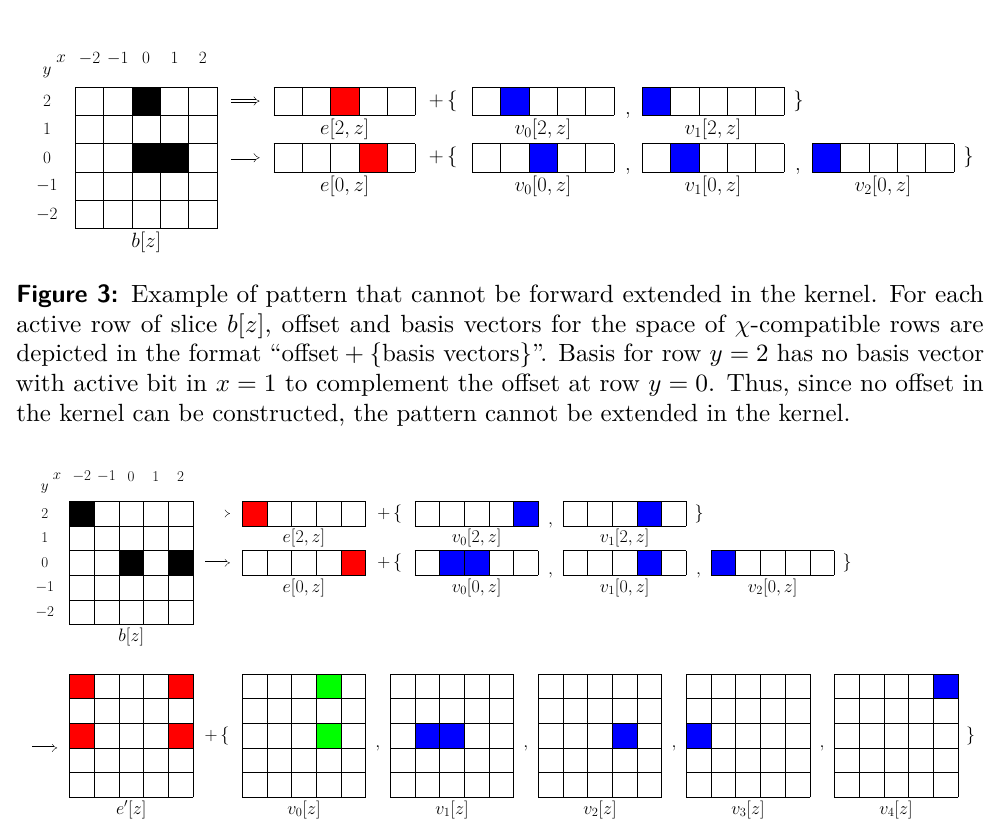
Figure 4: Example of pattern that can be forward extended in the kernel. Above, offset and basis vectors for the space of χ -compatible rows are depicted. Below, offset and basis vectors for the space of χ -compatible slices are depicted, with separation between basis vectors in the kernel (in green) and outside the kernel (in blue). The offset in the kernel can be built as e 0 [ z ] = e [0 , z ] + e [2 , z ] + v 0 [2 , z ] + v 2 [0 , z ], thus the pattern can be forward extended in the kernel. Vector v 0 [ z ] = v 1 [0 , z ] + v 2 [2 , z ] forms the basis for V K [ z ],